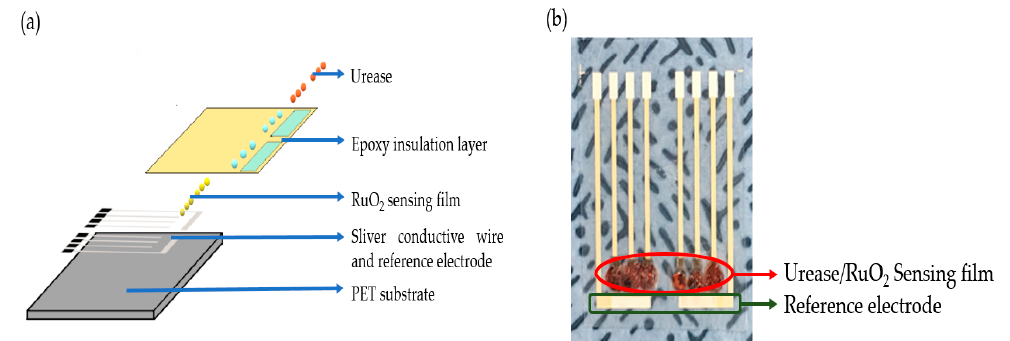
Figure 1. ( a ) The structure diagram of the flexible arrayed RuO 2 urea biosensor, and ( b ) top view of the completed flexible arrayed RuO 2 urea biosensor.